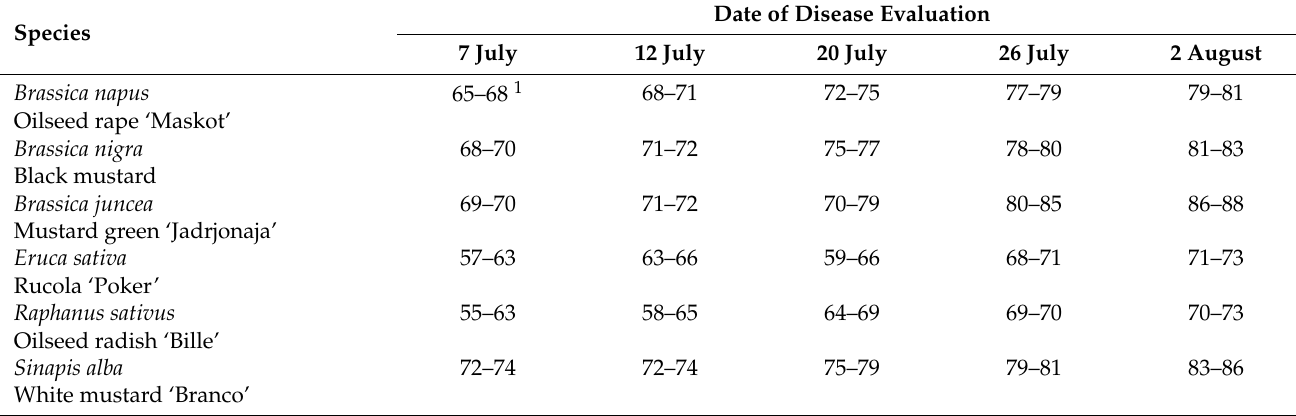
Table 1. Growth stages (GS) of studied cruciferous species at each observation date in